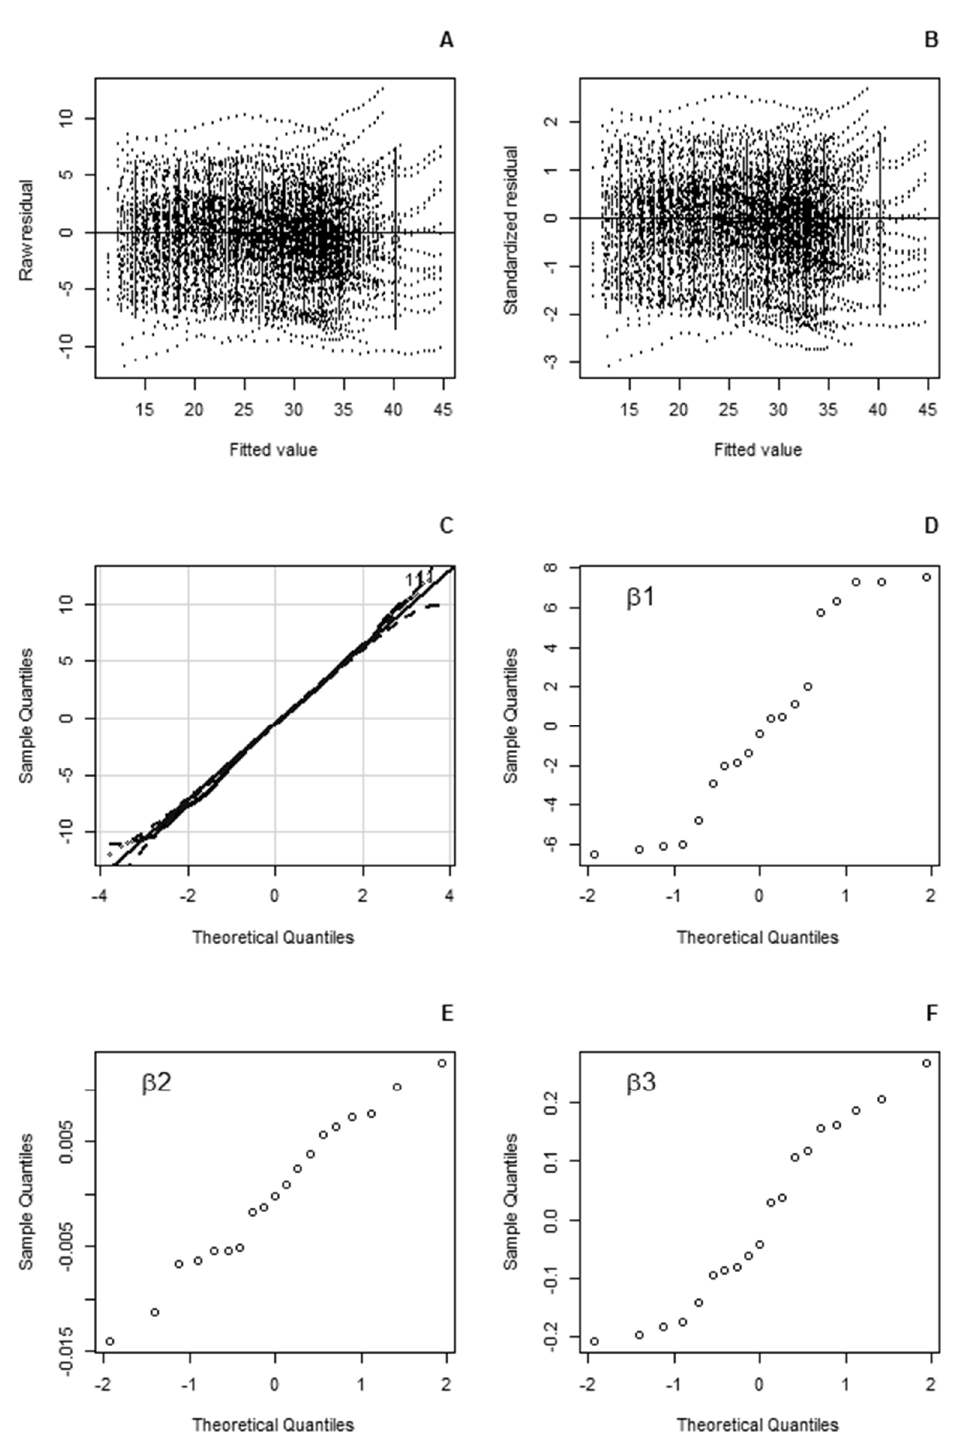
Figure 2. Statistics of the final fitted Chapman–Richard mixed model that was applied to investigate the clone effect of the diameter–age relationship on the parameters: ( A , B ) plots of raw ( A ) and standardised ( B ) residuals for the final equation. The whiskers denote the 95% confidence intervals of the residuals for the classified fitted values. ( C ) Quantile–quantile plot of the final fitted model. ( D – F ) Normal plots of the estimated random effects of the asymptotic diameter parameter β 1 ( D ), the rate parameter β 2 ( E ) and the shape parameter β 3 ( F ) for the final fitted model.